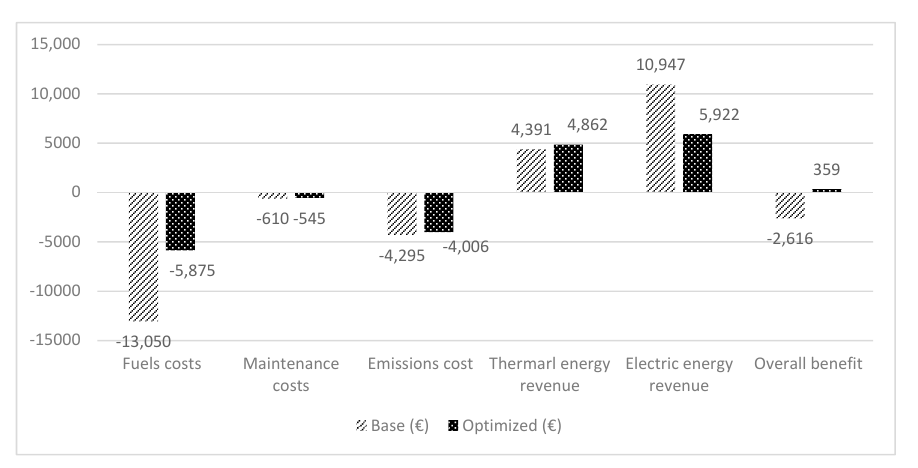
Figure 13. Optimized engine, burner, and boiler ON/OFF.